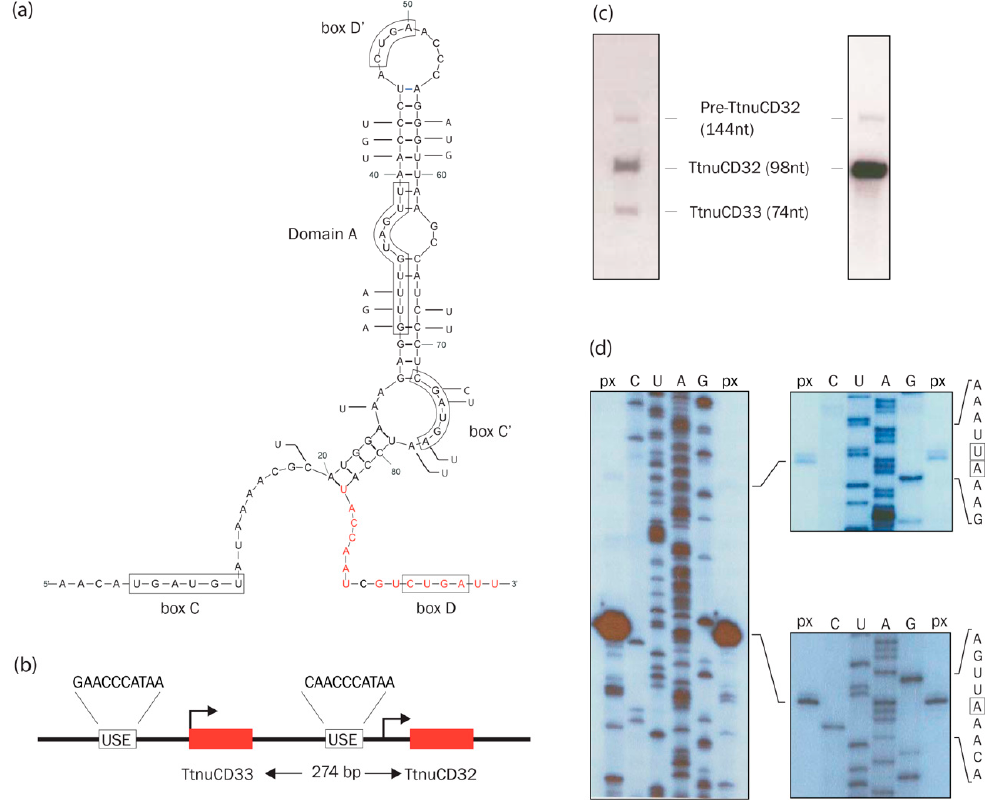
Figure 2. Mapping and structure analysis of the box C/D snoRNA TtnuCD32: ( a ) Secondary structure of TtnuCD32 derived by thermodynamic folding, structure probing, and comparative sequence analysis. Boxes C, C’, D, and D’, as well as a putative domain A are framed. Sequence variation between TtnuCD32 and the homolog from T. pyriformis (TpnuCD32) are noted by letters next to the sequence. Nucleotides involved in the non-canonical long interaction with 26S rRNA discussed in Figures 4 and S2 are highlighted in red; ( b ) Genomic organization of the TtnuCD32 and TtnuCD33 genes. Sequences encoding the mature snoRNA are shown as red boxes. Upstream promoter elements (USE) are indicated; ( c ) Northern blot analysis of TtnuCD32 and TtnuCD33 on 10 µg nuclear RNA. The membrane in the left panel was hybridized with a probe produced from a 1.8 kbp genomic fragment containing both TtnuCD33 and TtnuCD32. For the right panel a TtnuCD32 specific probe was applied; ( d ) Mapping the TtnuCD32 5 ′ end. Primer extension analysis was performed (lanes marked px) and analyzed in parallel with a dideoxy-sequencing reaction of the cloned TtnuCD33/32 fragment (lanes marked C, U, A, and G) (left panel). The right panels show a magnification of the relevant parts of the autoradiogram with the inferred 5 ′ -nucleotide framed in the sequence display. The second-best scoring target prediction (II) resembled a canonical box C/D snoRNA interaction in Tetrahymena, that generally are shorter than what observed for e.g., vertebrates [7,29]. However, even for a Tetrahymena box C/D snoRNA this interaction must be considered weak and with a centrally located mismatch in the base-pairing also this candidate can be considered unlikely to guide a 2 ′ -O-me. The predicted interaction (III) between TtnuCD32 and 26S rRNA position 3031–